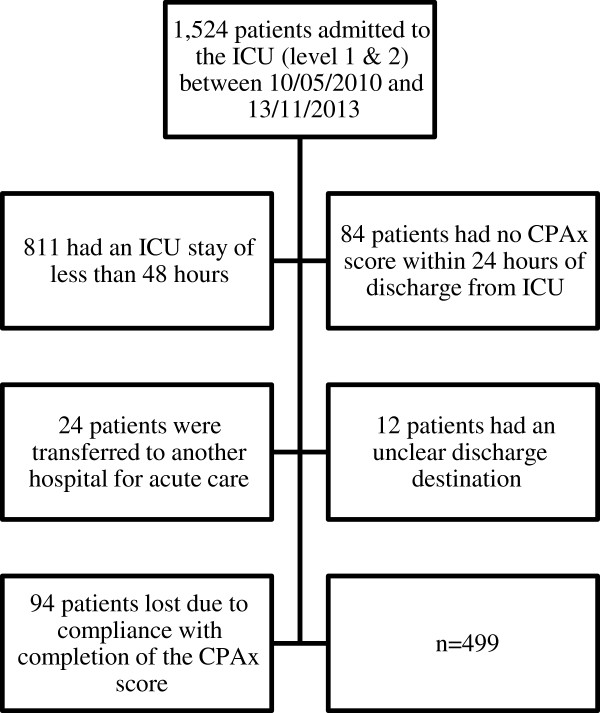
Consort diagram.